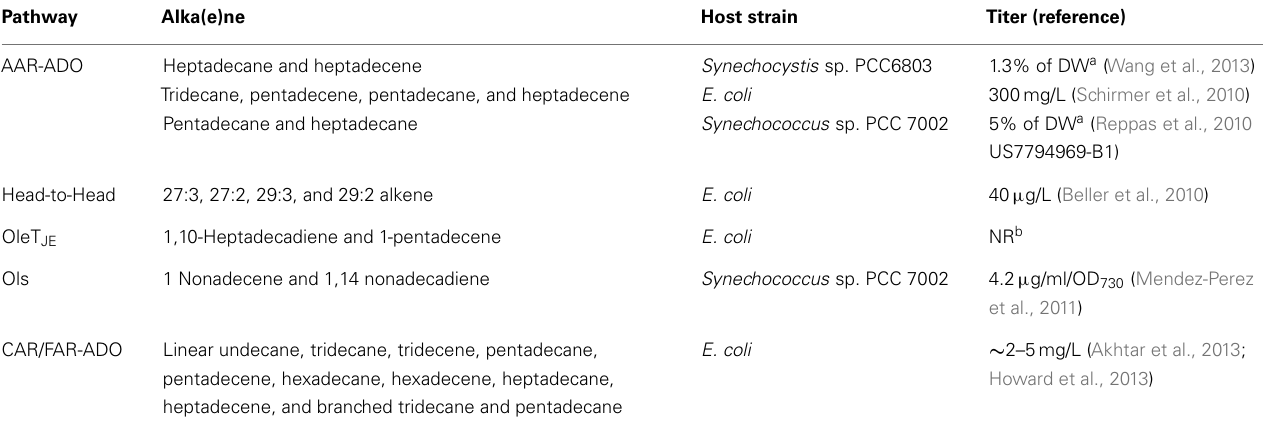
Table 1 | Production level reported for the five alka(e)ne biosynthetic